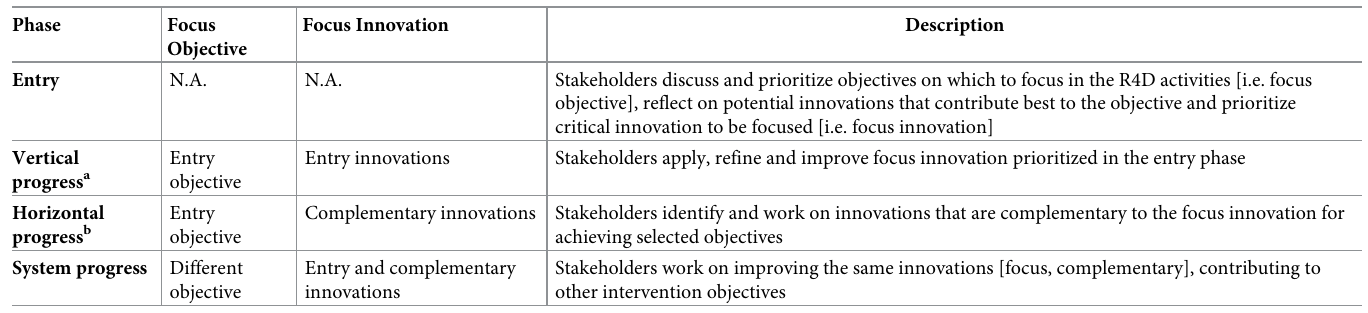
Table 2. R4D objective based phases when participation is organized through